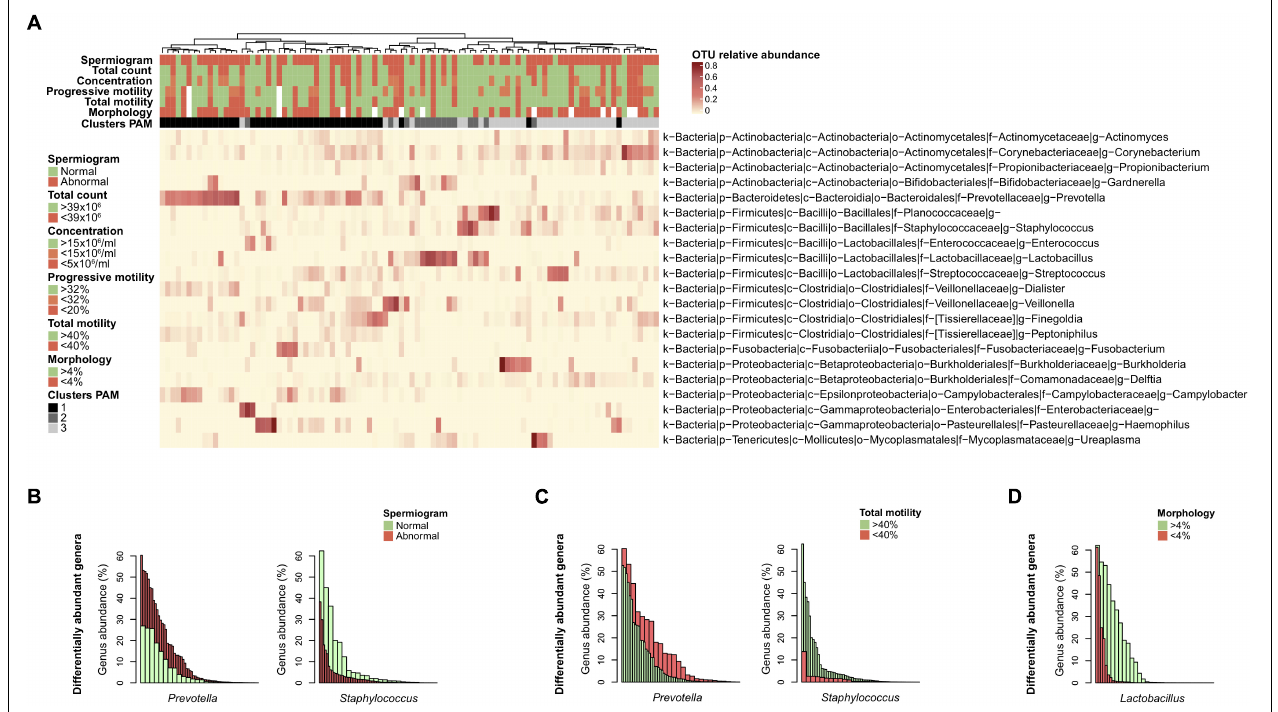
FIGURE 4 | Differentially abundant bacterial genera with semen parameters. (A) Heatmap of the most abundant genera ( > 1% mean relative abundance) with corresponding Ward linkage dendrogram based on the Bray Curtis distance matrix at genus level. Each column represents an individual sample and color-scale bar indicating operational taxonomic unit (OTU) relative abundance. Samples grouping according to spermiogram and microbiota profile (1- Prevotella -enriched, 2- Lactobacillus -enriched and 3-polymicrobial) are indicated as column annotations. OTUs are labeled based on their phylum (p), class (c), order (o), family (f), and genus (g). (B) Bar plot representation of differentially abundant bacterial genera as determined by linear discriminant analysis effect size (LEfSe) analysis comparing spermiogram groups. (C) Same analysis comparing total motility groups. (D) Same analysis comparing morphology groups. Each bar is colored according to its belonging to normal (green) or abnormal (red)